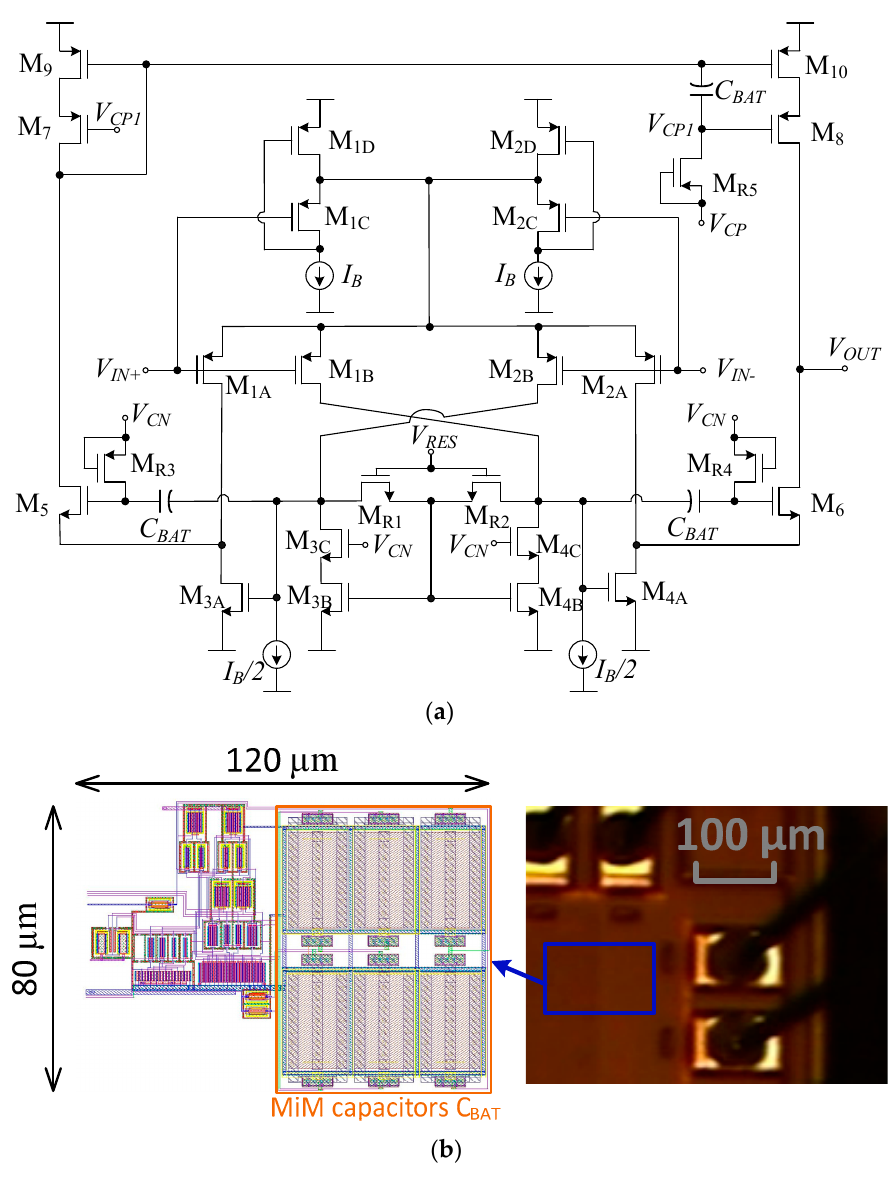
Figure 8. Proposed super class AB QFG amplifier. ( a ) Circuit diagram. ( b ) Microphotograph (layout image also included, due to the opaque die passivation layer).